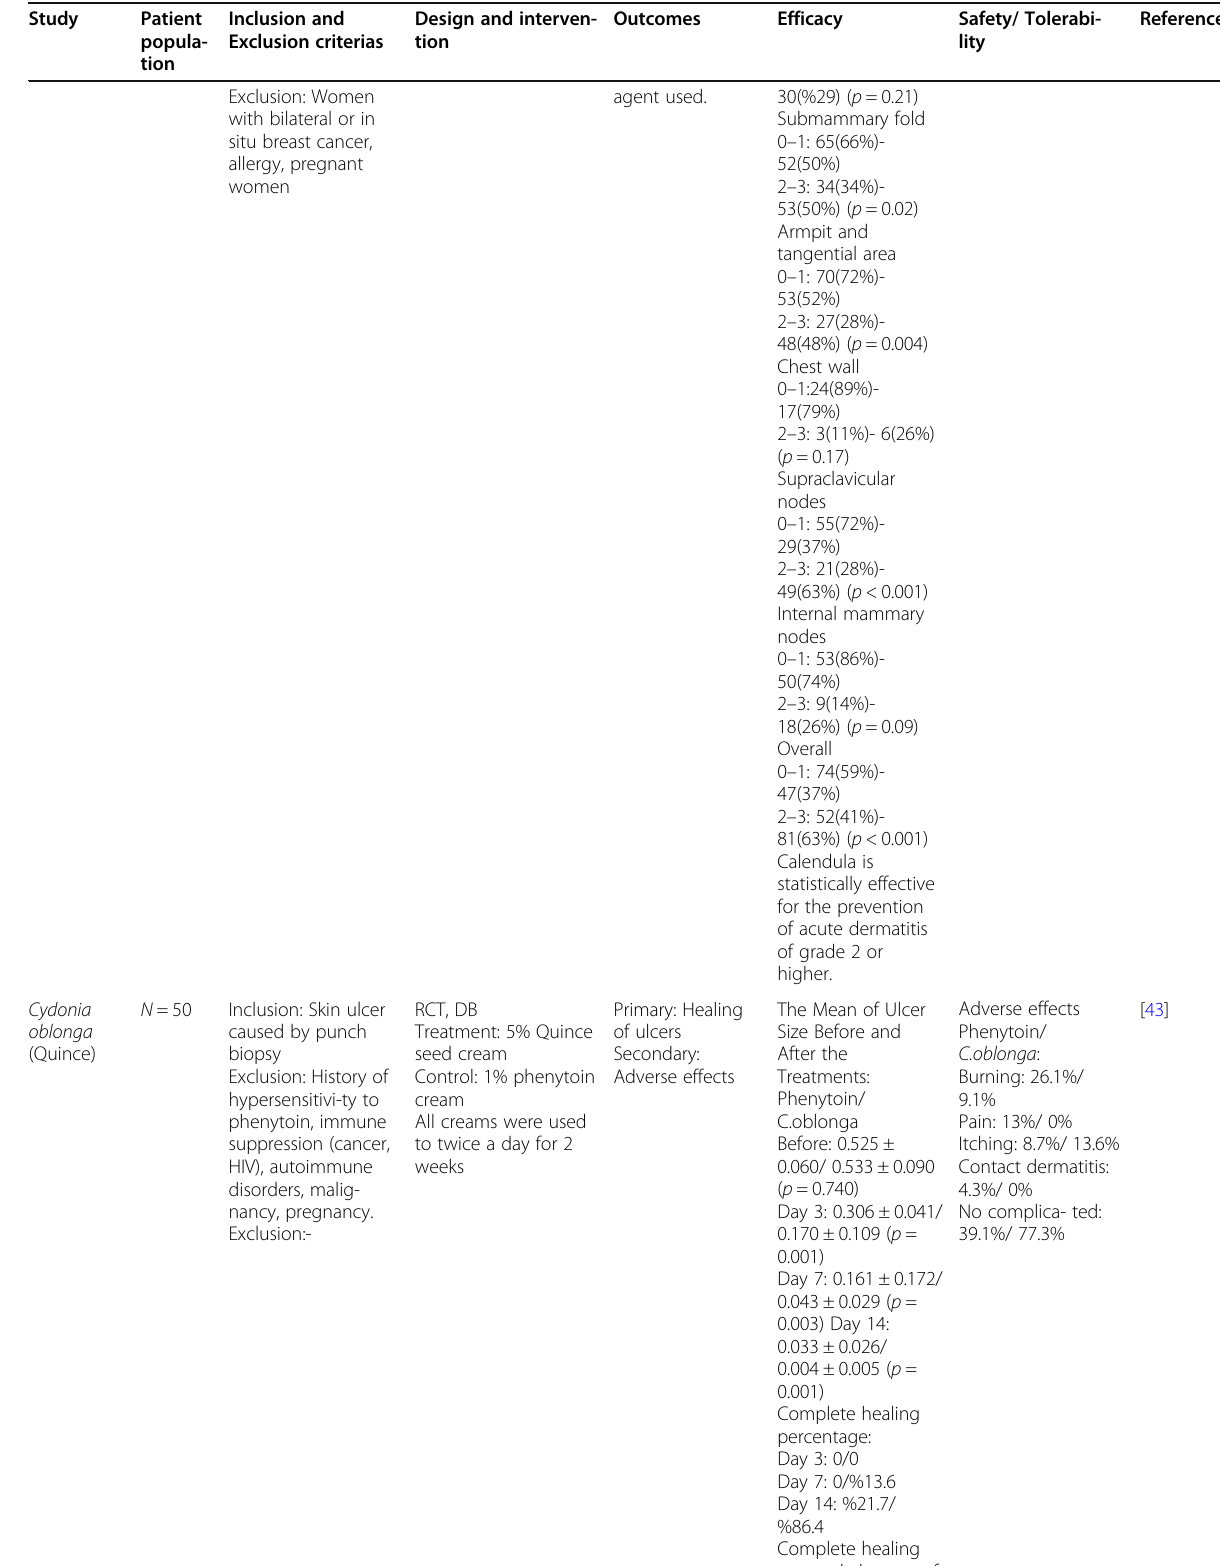
Table 4 Clinical trials of the traditional plants used for skin problems in Turkey (Continued) Study Patient